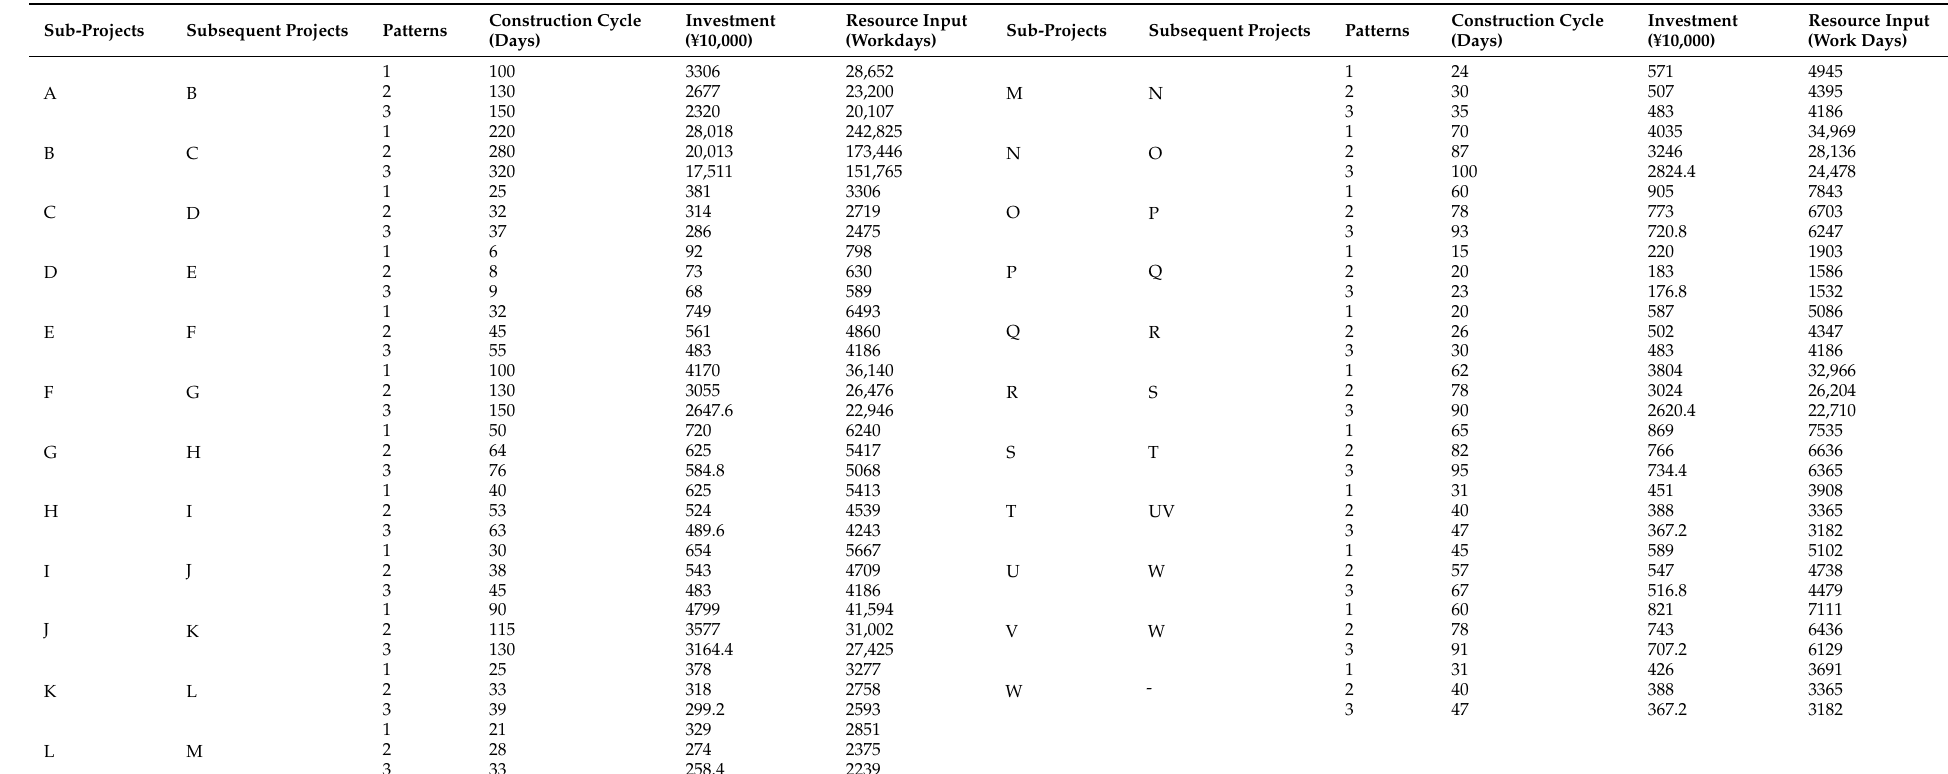
Table 1. Relevant parameter information for the case of power grid